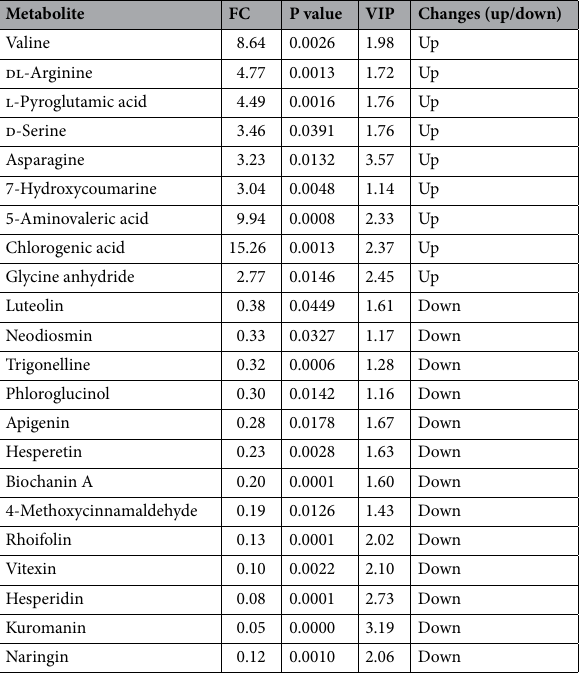
Table 1. Metabolomic analysis of the sugarcane stalks in BS compared to SS. BS bitter sugarcane group, SS sweet sugarcane group, FC fold change, VIP variable importance in projection.